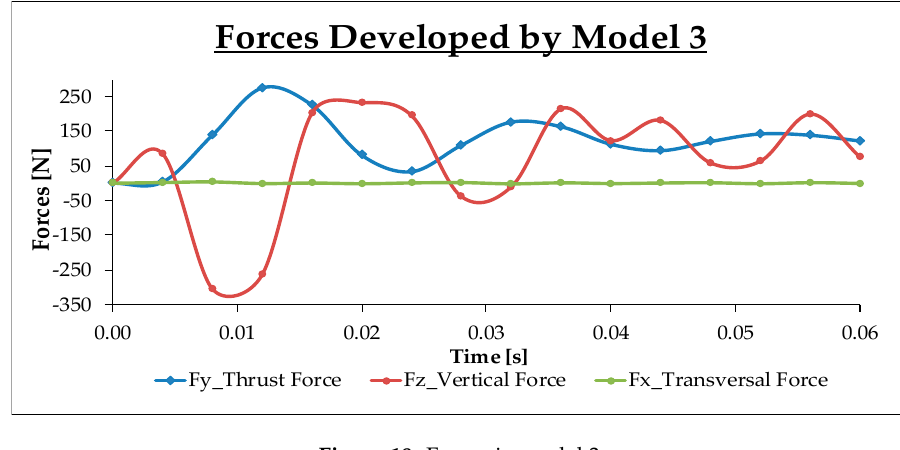
Figure 18. Forces in model 3.